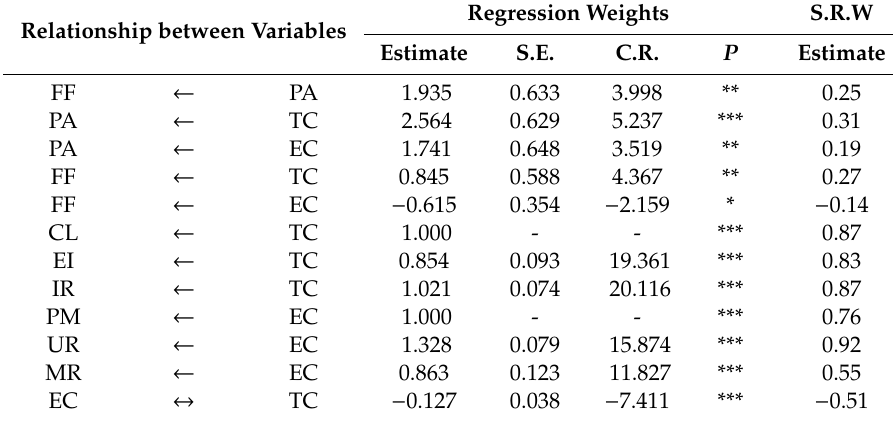
Figure 2. Structural Equation Model in Spanish university students. Note: IR, important role; EI, e ff ort / improvement; CL, cooperative learning; PM, punishment for mistakes; UR, unequal recognition; MR, member rivalry. Table 1. Regression weights for university students from